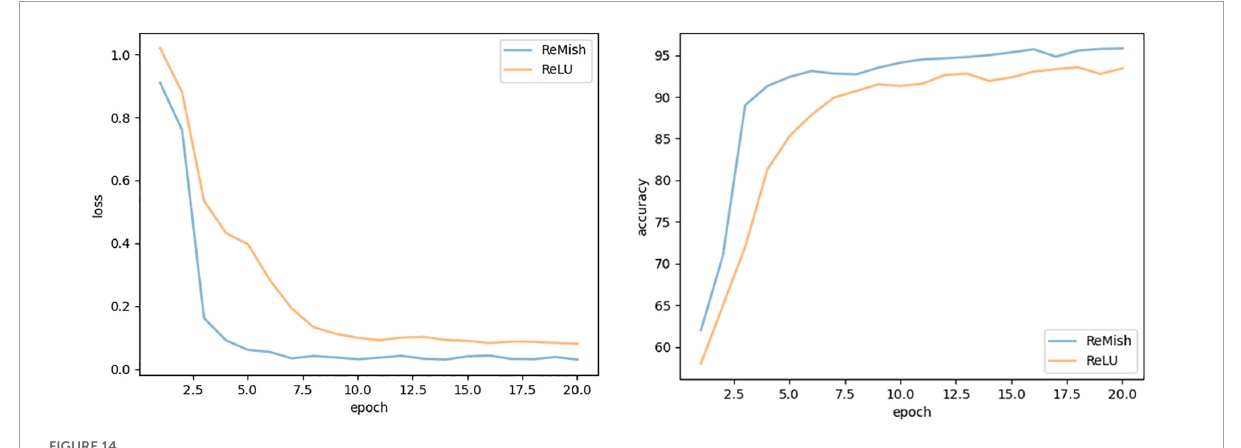
FIGURE14 Performance comparison of ReLU and ReMish.